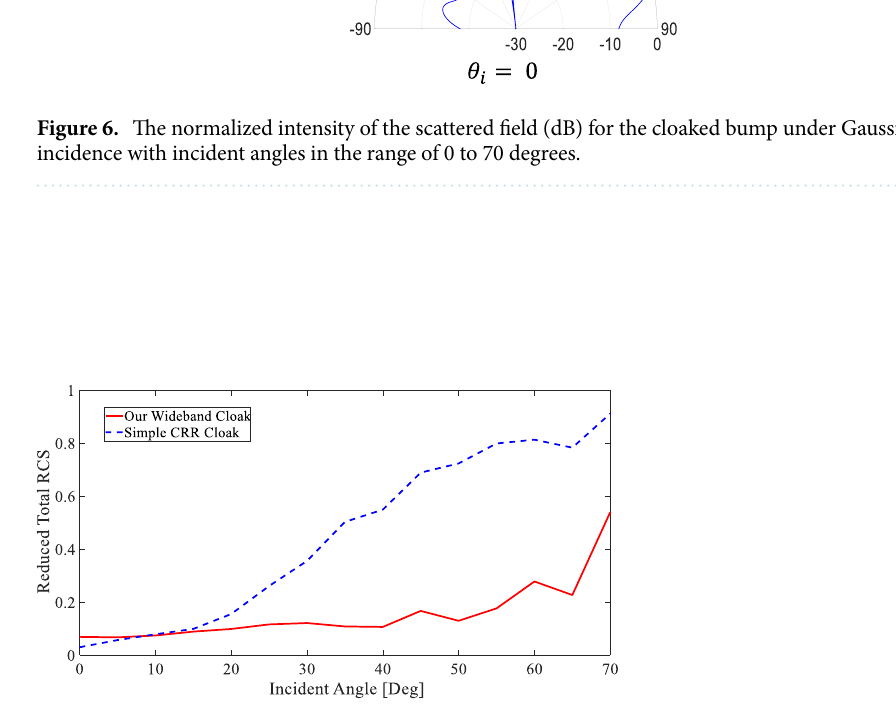
Figure 7. Reduced Total RCS for the proposed cloak (solid red diagram) is compared with that of a simple cloak designed using CRR unit cells (dash blue